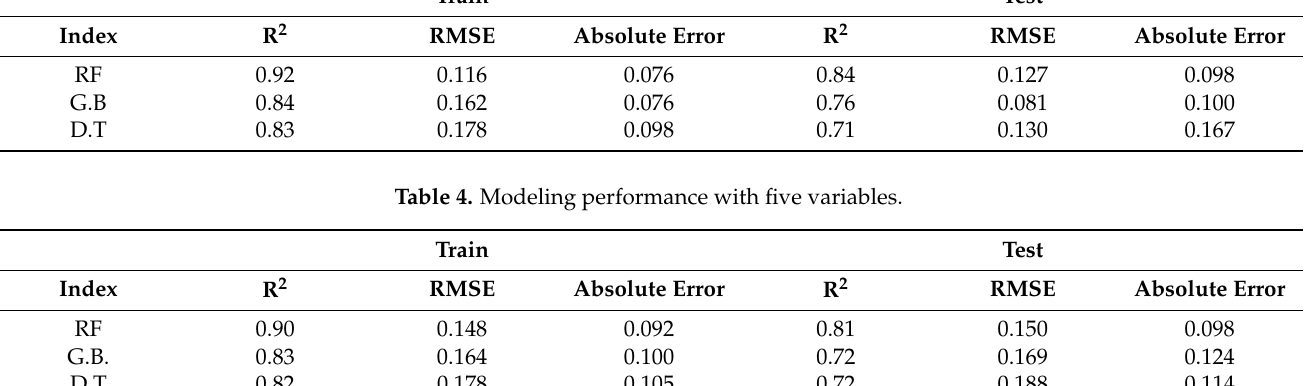
Table 3. Modeling performance with nine variables. Train Test